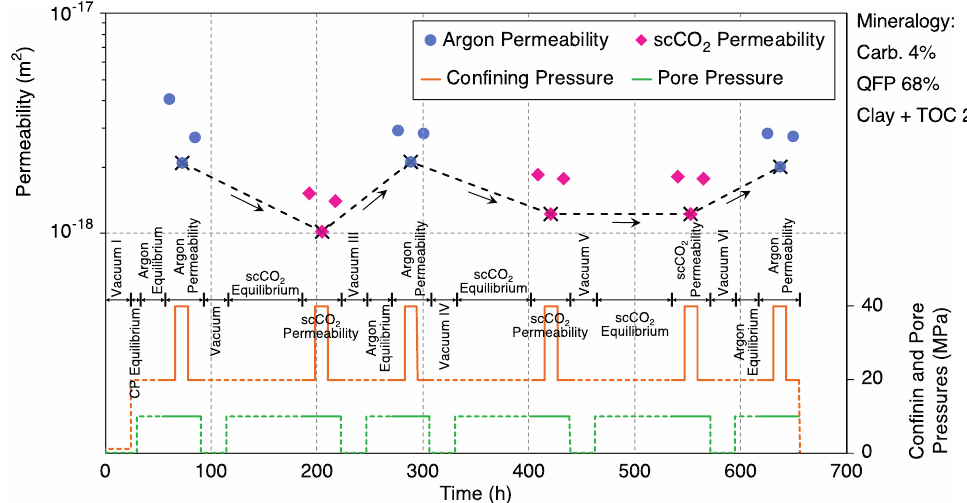
Figure 8. Permeability changes for sample 3-2H.